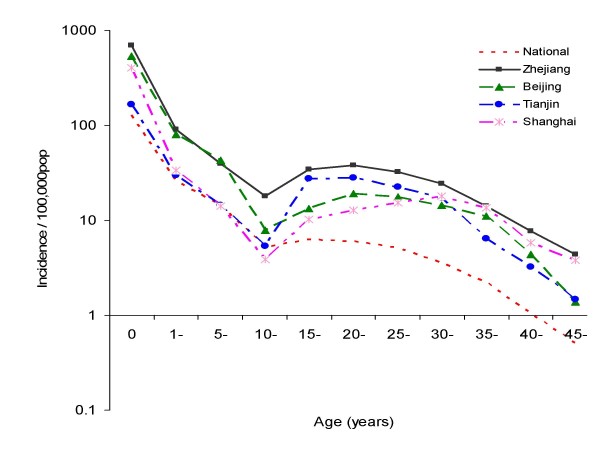
Age-specific incidence of measles at the national level and Zhejiang, Beijing, Tianjin and Shanghai in 2005, China.